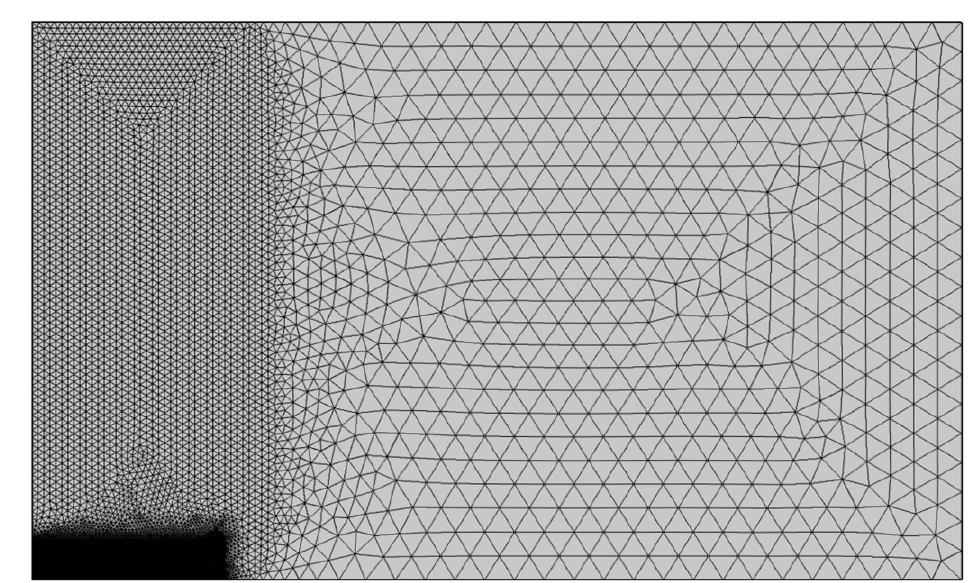
Figure B2: Mesh geometry in the models with eight thin sills.